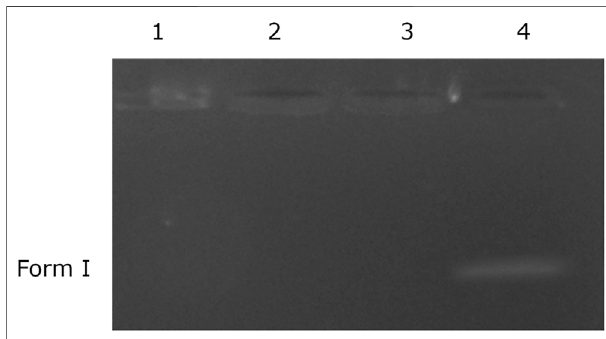
FIGURE 6 | DNA cleavage of iron oxide nanoparticle. Lane 1, pBR 322 DNA + 125 mg/L of Fe nanoparticle; Lane 2, pBR 322 DNA + 250 mg/L Fe nanoparticle; Lane 3, pBR 322 DNA + 500 mg/L of Fe nanoparticle; Lane 4, pBR 322